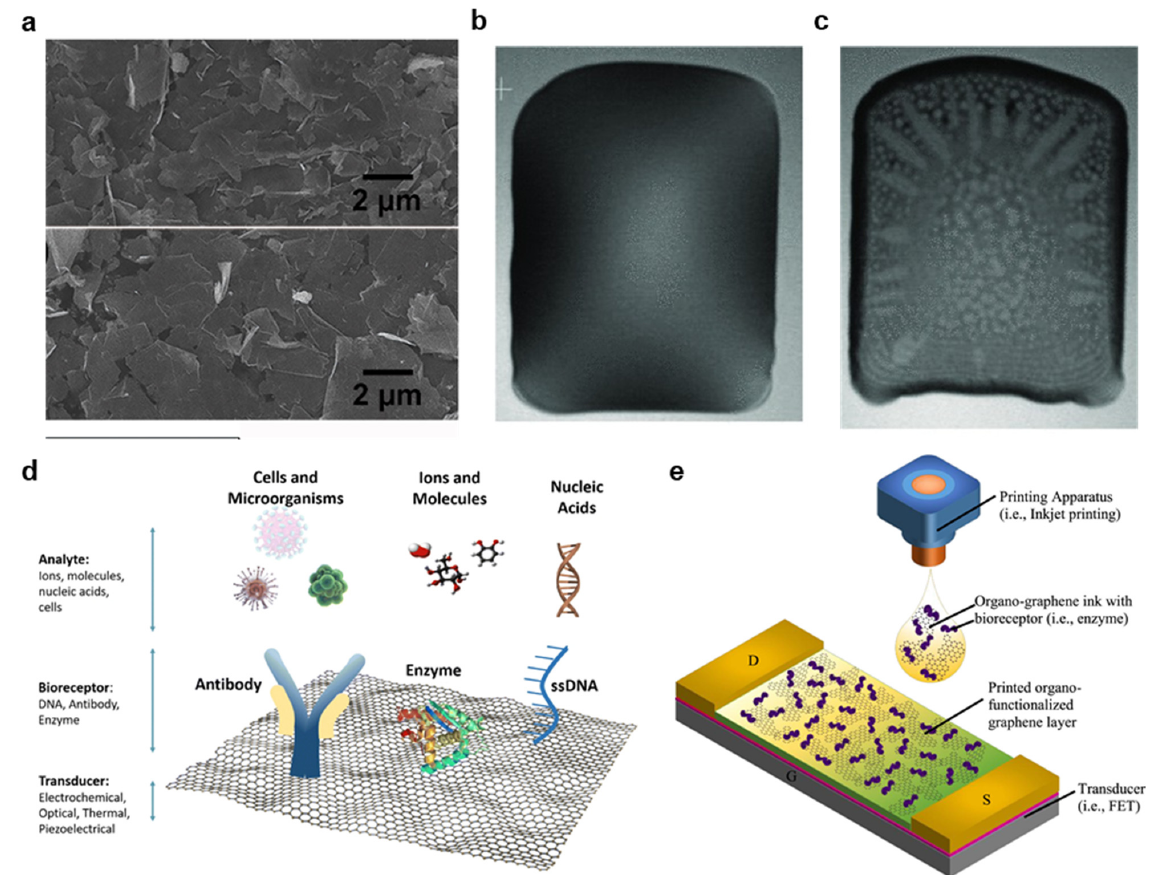
Figure 8. Graphene printing and functionalization for bioelectronics sensors. ( a ) Atomic force microscopy (AFM) images of screen-printed graphene (reprinted with permission from J. Colloid Interface Sci. (2021), 582(A), 15. Copyright 2021, Elsevier). ( b , c ) SEM images of an inkjet-printed graphene deposition ( b ) before and ( c ) after curing, with a minor coffee ring effect. (reprinted with permission from Adv. Mater. (2013), 25(29), 3985–3992. Copyright 2013, Wiley). ( d ) Examples of covalently bonded bioreceptors on a functionalized GO deposition. (reprinted with permission from J. Nanobiotechnol. (2018), 16,75. Copyright 2018, Springer Nature). ( e ) Graphical depiction of a FET biosensor with organo-functionalization. (reprinted with permission from Biosens. Bioelectron. (2017). 87, 7–17. Copyright 2017, Elsevier).